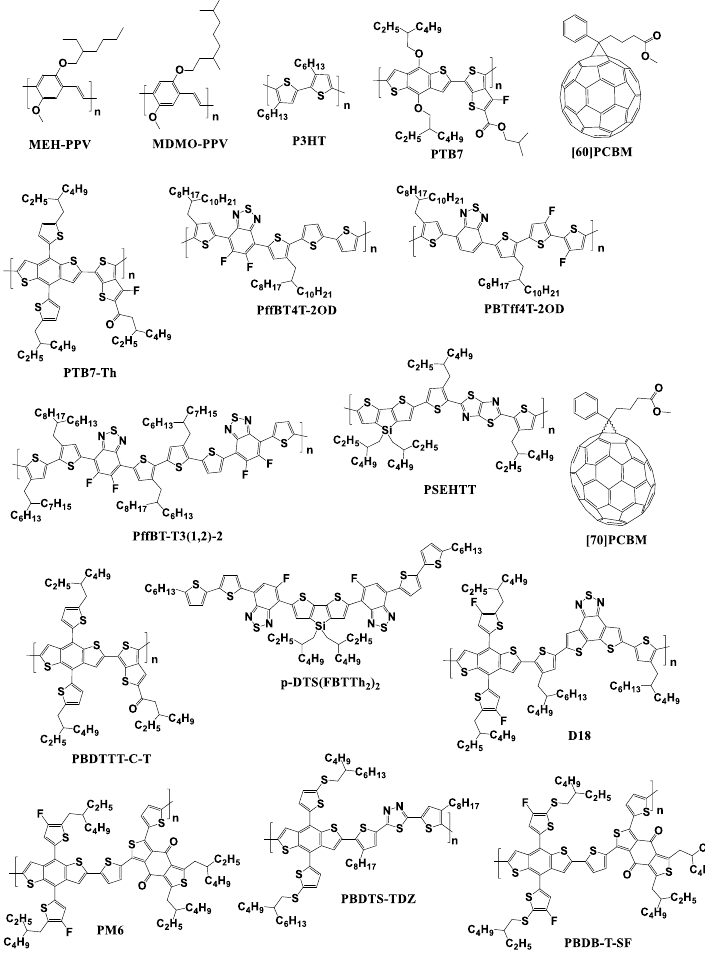
Figure 6. Molecular structures of some of the fullerene-based acceptors and electron donor materials playing a historical role in the development of OSCs.